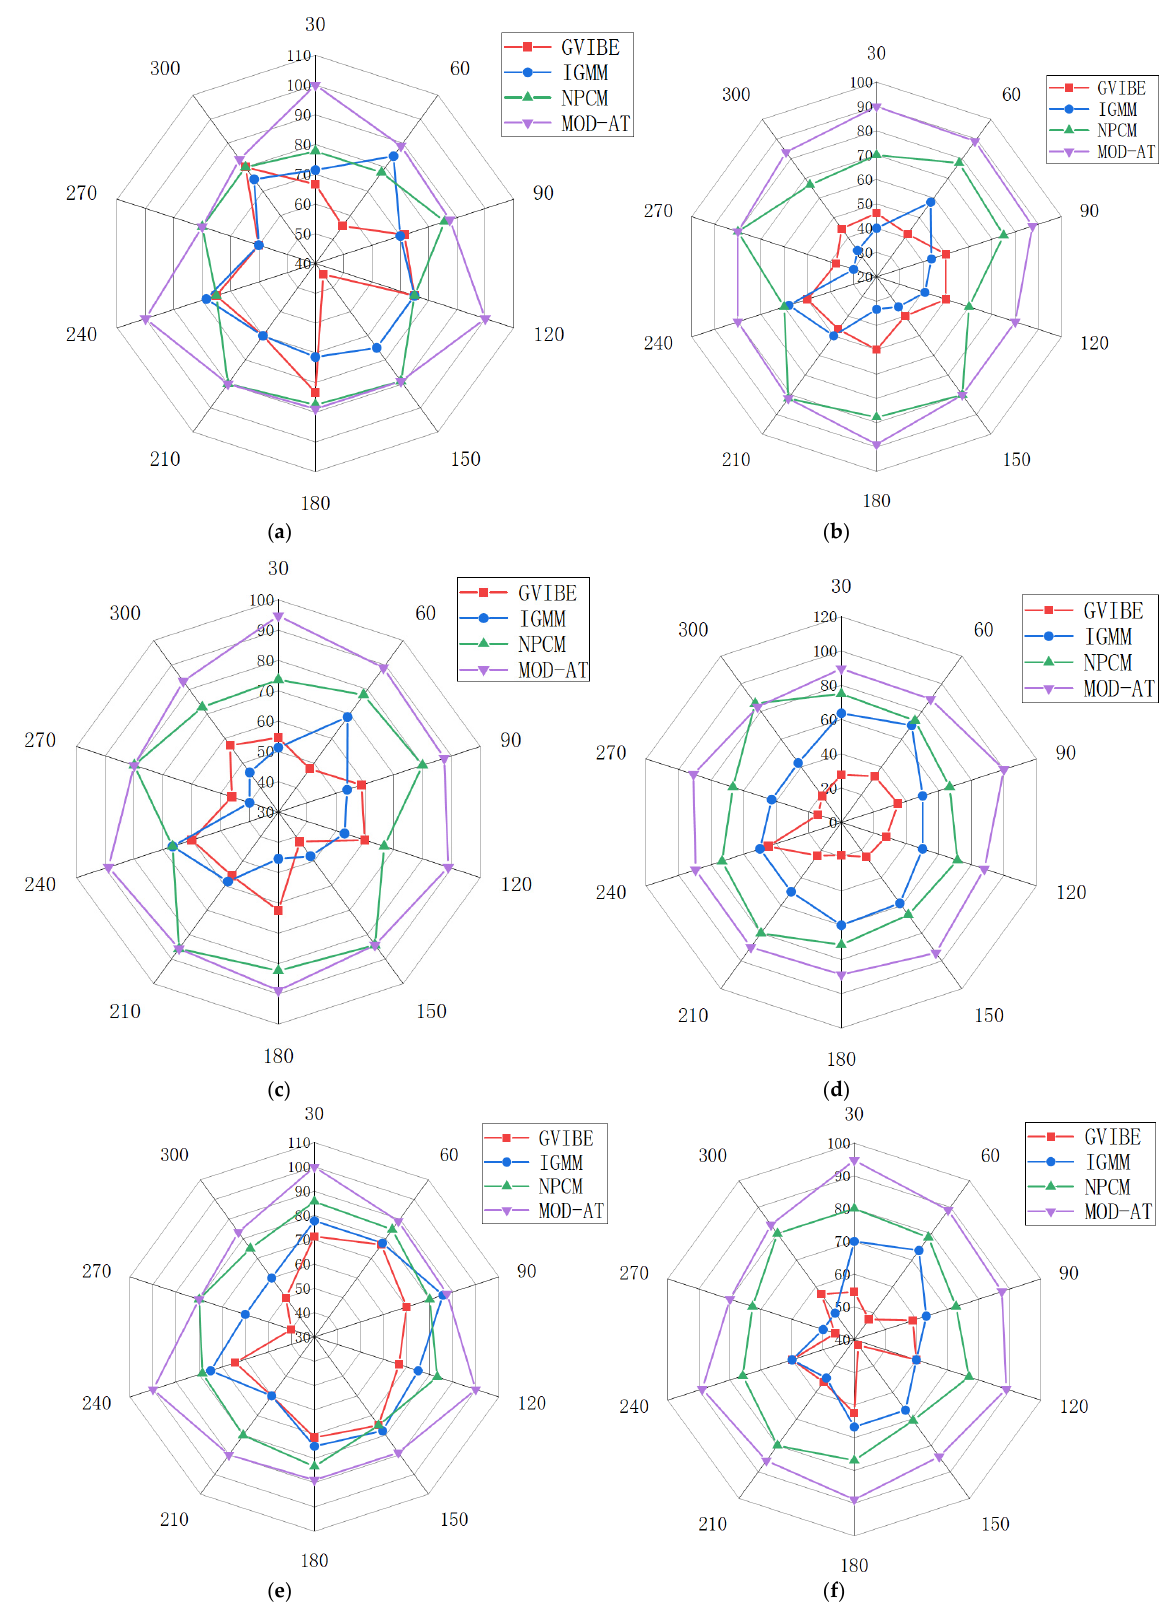
Figure 11. Comparison of MOD-AT and other algorithms: ( a ) the precision comparison of video #1; ( b ) the recall comparison of video #1; ( c ) the F1 score comparison of video #1; ( d ) the precision comparison of video #2; ( e ) the recall comparison of video #2; ( f ) the F1 score comparison of video #2.